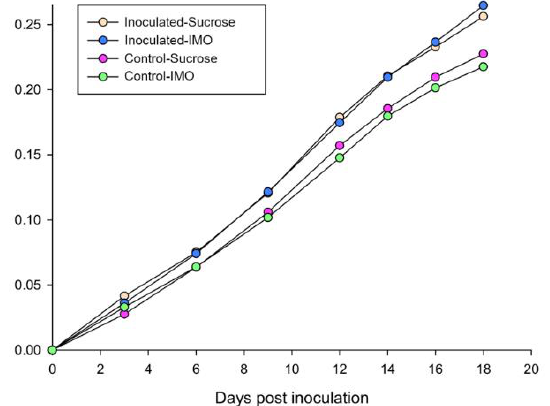
Figure 1. Accumulated sugar water consumption of the four honey bee treatment groups. Y-axis indicates the accumulated sugar–water consumption in grams. The four treatment groups were generated by two variables: IMO/sucrose and V. ceranae inoculation/control.